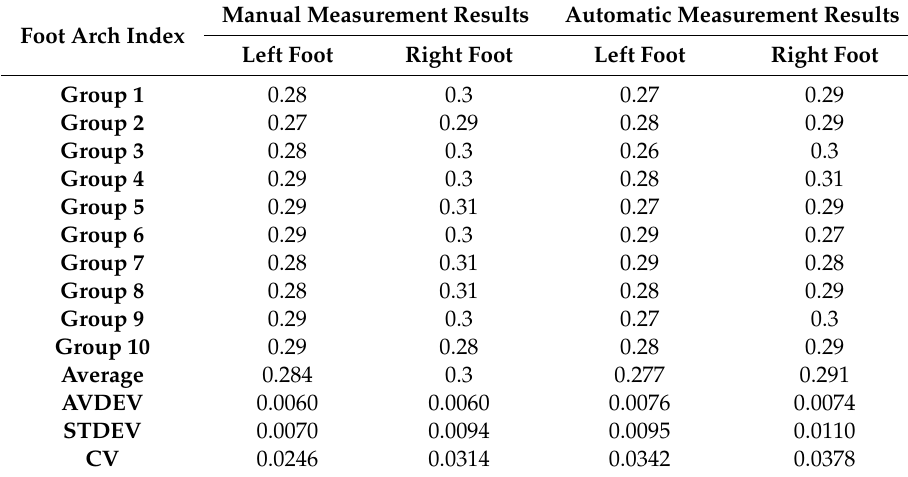
Table 3. Results of the two measurement methods for the flat feet.